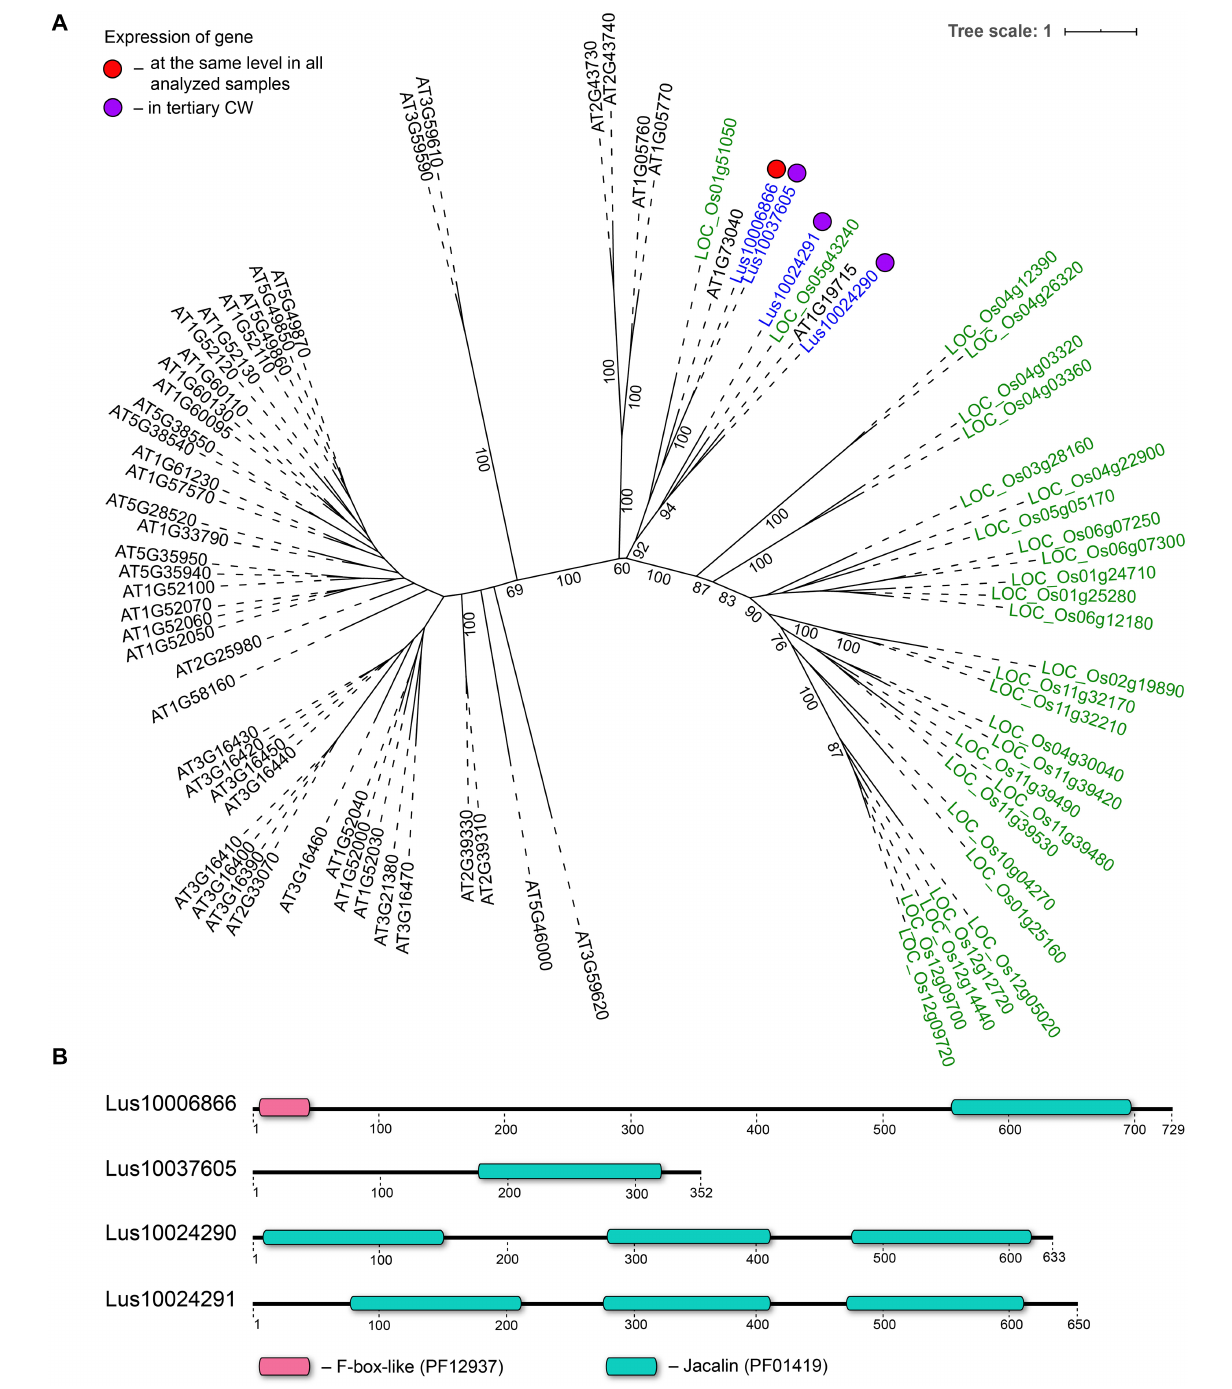
Frontiers in Plant Science |